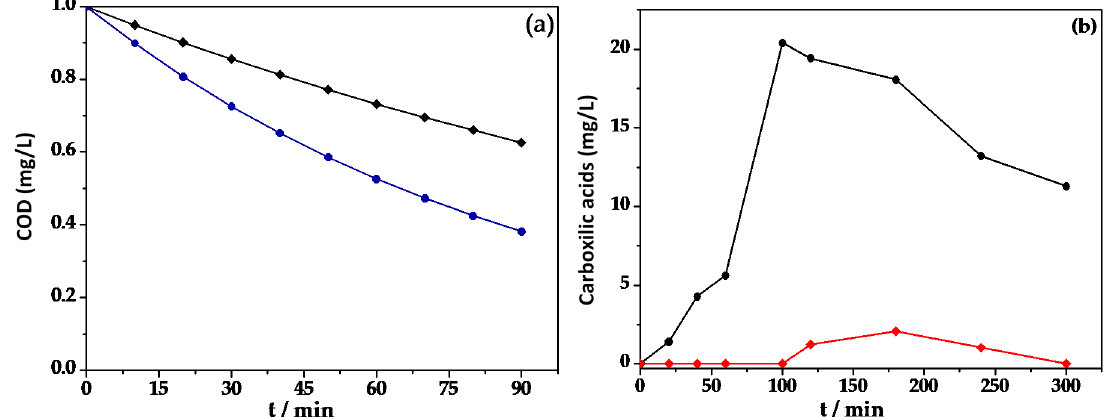
Figure 8. ( a ) Variation of COD abatement for 50 mg / L of BBR azo dye using BDD electrolysis without Figure 8. a ) Variation of COD abatement for 50 mg/L of BBR azo dye using BDD electrolysis without FeSO 4 ( (cid:7) ) and the simultaneous EOx / [Fe(VI)] process using 12 mM of FeSO 4 ( • ) in 0.05 M of Na 2 SO 4 FeSO 4 ( ♦ ) and the simultaneous EOx/[Fe(VI)] process using 12 mM of FeSO 4 ( • ) in 0.05 M of Na 2 SO 4 at a pH of 3 at 30 mA cm − 2 . ( b ) Evolution of the concentration of oxalic acid produced during the at a pH of 3 at 30 mA cm -2 . b ) Evolution of the concentration of oxalic acid produced during the degradation of 0.4 L of 50 mg / L BBR solution in 0.05 M of Na 2 SO 4 at a pH of 3 and 35 ◦ C using BDD degradation of 0.4 L of 50 mg/L BBR solution in 0.05 M of Na 2 SO 4 at a pH of 3 and 35 °C using BDD without FeSO 4 ( • ) and the simultaneous EOx / [Fe(VI)] process using 12 mM of FeSO 4 ( (cid:7) ) at 30 mA cm − 2 without FeSO 4 ( • ) and the simultaneous EOx/[Fe(VI)] process using 12 mM of FeSO 4 ( ♦ ) at 30 mA cm -2 .